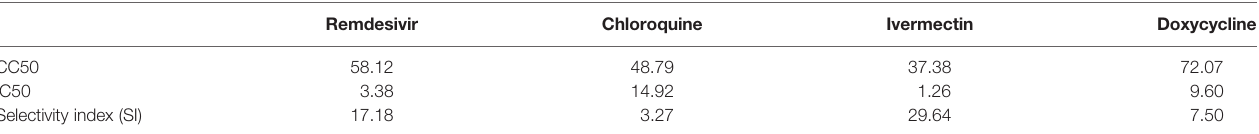
TABLE 1 | Mean values of CC50, IC50 and selectivity index (SI = CC50/EC50) of remdesivir, chloroquine, ivermectin and doxycycline treatment of RAW264.7